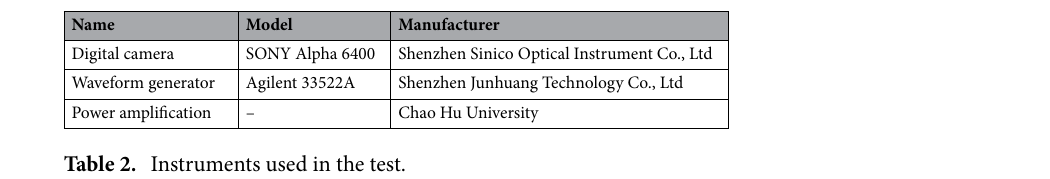
Table 2. Instruments used in the test.